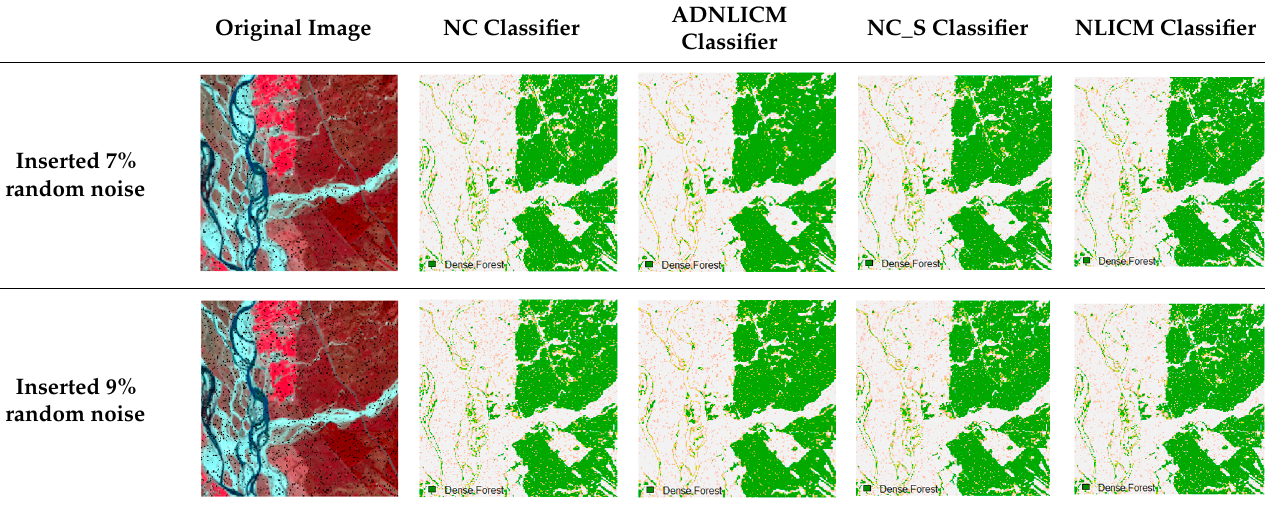
Table 7. Landsat-8 original and dense forest classified class image with respect to different random salt-and-pepper noise (for site 1 (Haridwar)).